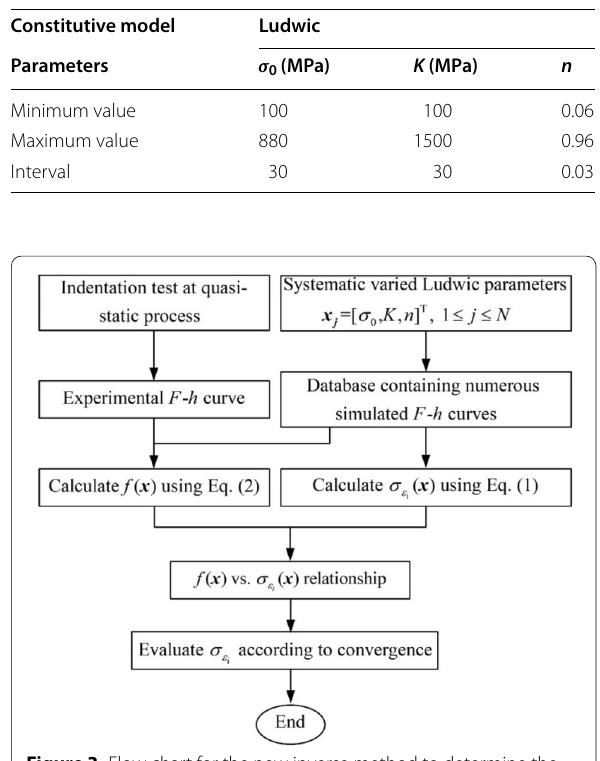
Figure 3 Flow chart for the new inverse method to determine the flow properties of metal materials